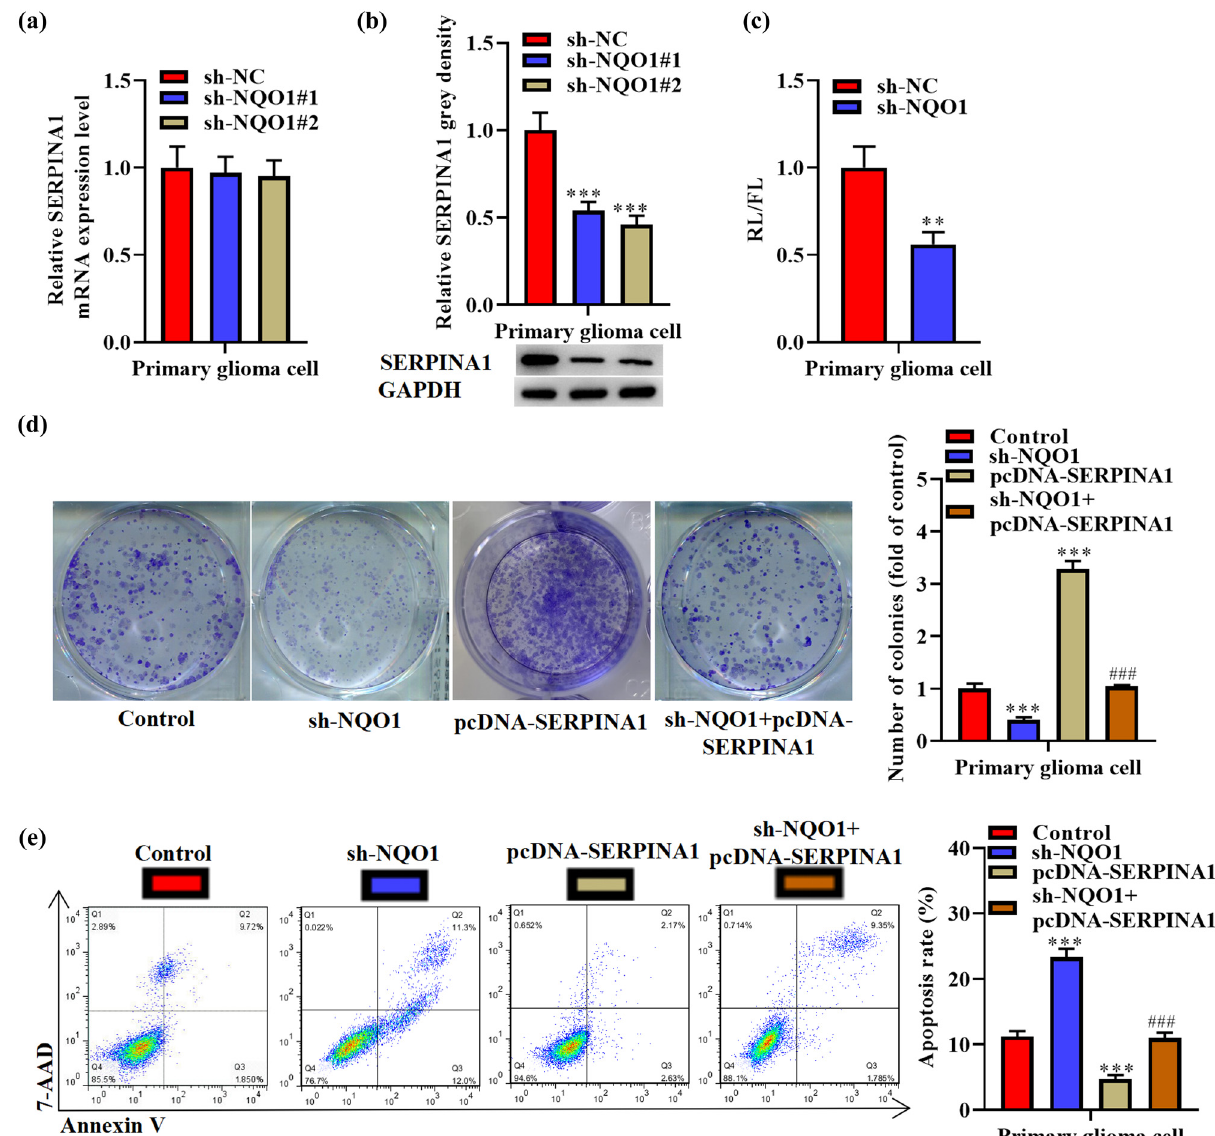
Figure 5: NQO1 binds to the 3 ′ UTR of SERPINA1 mRNA and suppresses its translation, and SERPINA1 rescues e ff ects of sh - NQO1 on proliferation and apoptosis of primary glioma cells. ( a ) Expression of SERPINA1 in sh - NQO1#1/2 transfected primary glioma cells was assessed by qRT - PCR. One - way ANOVA was conducted. ( b ) SERPINA1 protein levels in sh - NQO1#1/2 transfected primary glioma cells. One - way ANOVA was conducted. ( c ) The ratios of FL/RL activity in sh - NQO1 transfected primary glioma cells. Student ’ s t test was conducted. ( d ) Colony formation assay results and quantitative analysis of primary glioma cells after transfection with sh - NQO1, pcDNA - SERPINA1, sh - NQO1 + pcDNA - SERPINA1. One - way ANOVA was conducted. ( e ) Annexin V/7AAD double staining assay results and quantitative analysis of primary glioma cells after indicated transfections. One - way ANOVA was conducted. Data are expressed as means ± SEM ( ** p < 0.01, *** p < 0.001 vs sh - NC or control, ### p < 0.001 vs sh - NQO1, n = 3 )